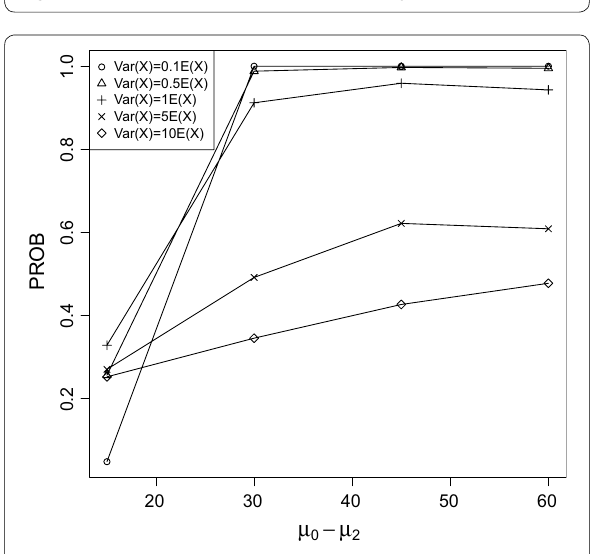
Fig. 8 PROB of the CPCAT; µ 0 = 25 , increasing trend